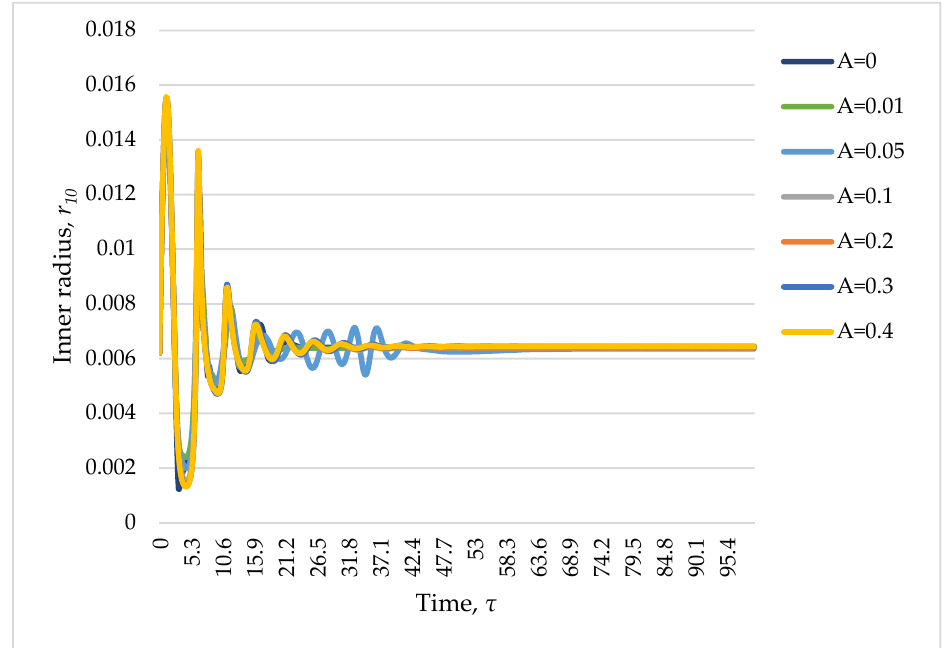
Figure 8. Oscillations in the values of the fiber radius in time (change in the amplitude of harmonic oscillations of the initial conditions).